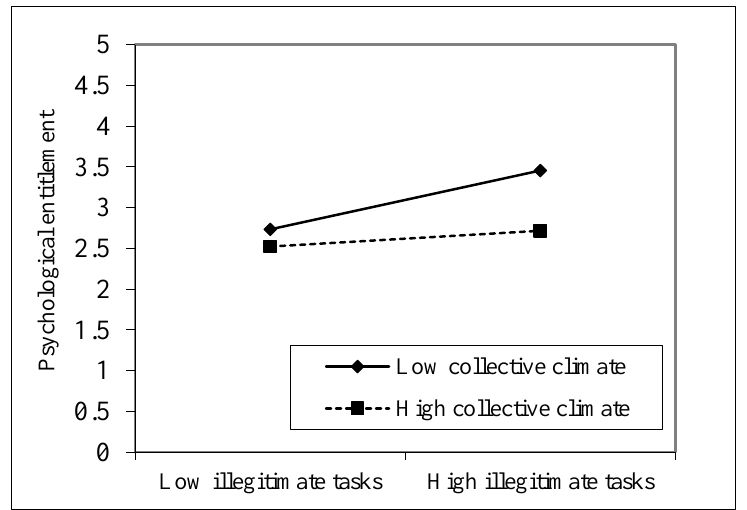
Figure 2. The moderating effect of collective climate on the relationship between illegitimate tasks and psychological entitlement.